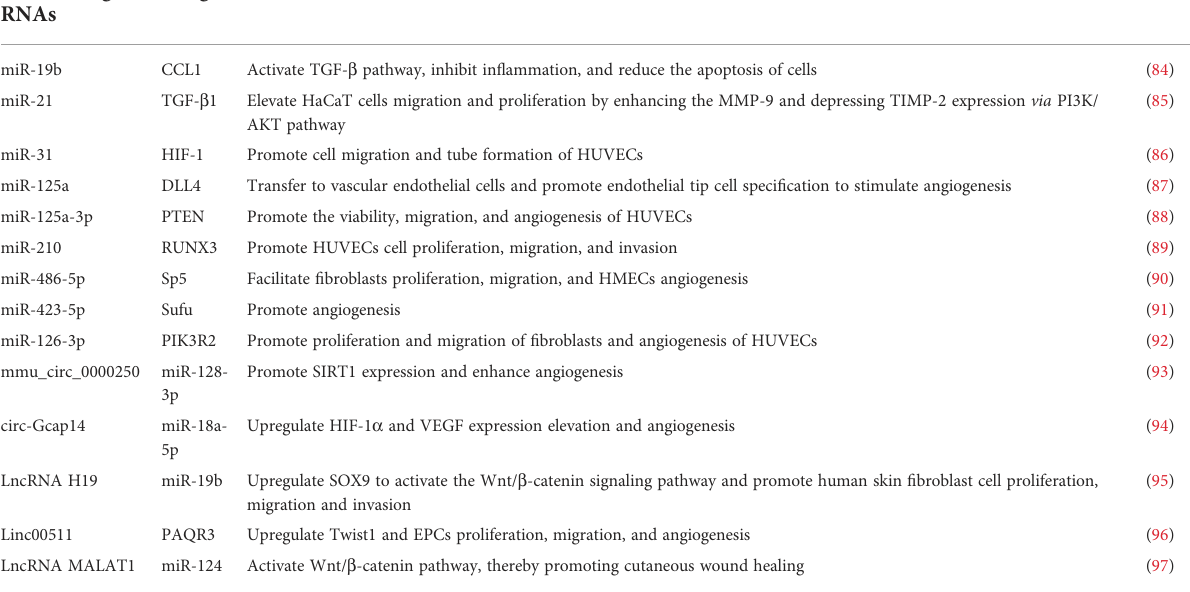
(Table 1). LncRNA H19 functions as a molecular sponge for miR-19b directly targeting SOX9 (encoding SRY-box transcription factor 9), so ADSCs-EVs with an overabundance of H19 suppressed miR-19b levels leading to SOX9 upregulation,